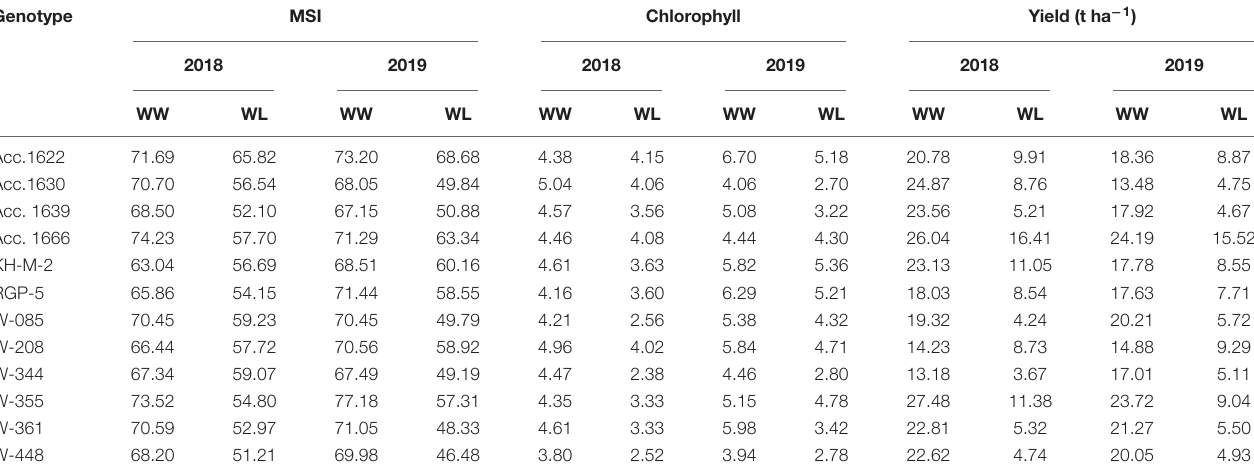
TABLE 7 | Physiological traits of contrasting onion genotypes evaluated under well-watered and waterlogging